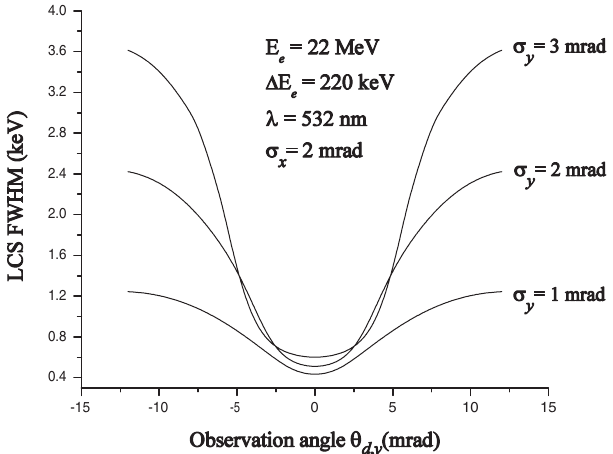
FIG. 13. Variation of LCS peak FWHM as a function of the with respect to the electron beam detector horizontal angle (cid:3) d;y direction for different values of (cid:6) . The direction of the scan is y perpendicular the laser polarization vector.